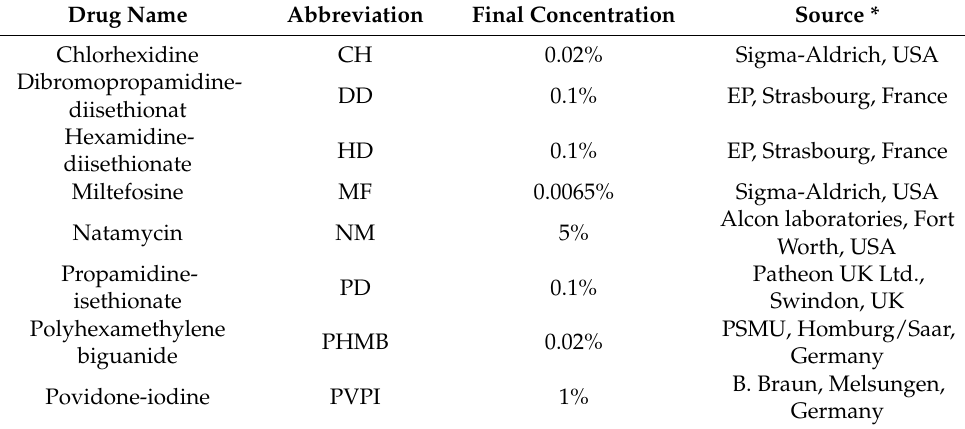
Table 1. Off-label anti-amoebic agents, drug concentrations used in experiments, and